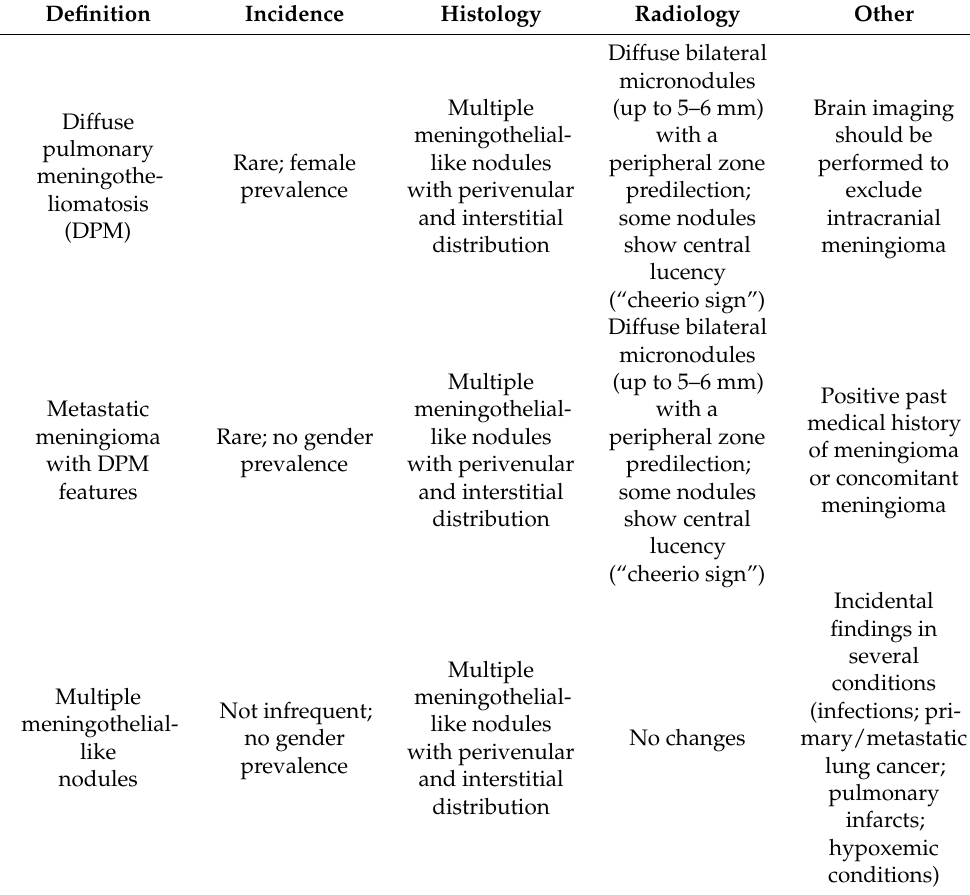
Table 4. Proposed definitions of conditions with multiple meningothelial-like nodules in the